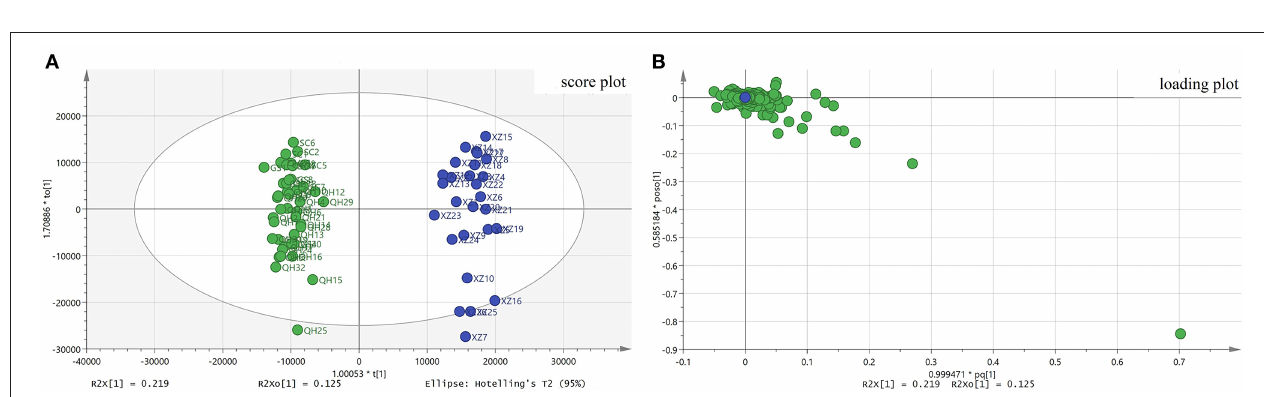
FIGURE 3 | PCA results of A. tanguticus. Score plot with the first two principal components of A. tanguticus (A) , Loading plot of PC1 and PC2 of A. tanguticus (B) .